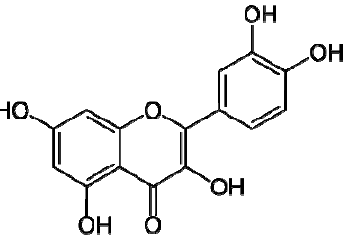
Figure 1. Chemical structure of quercetin.